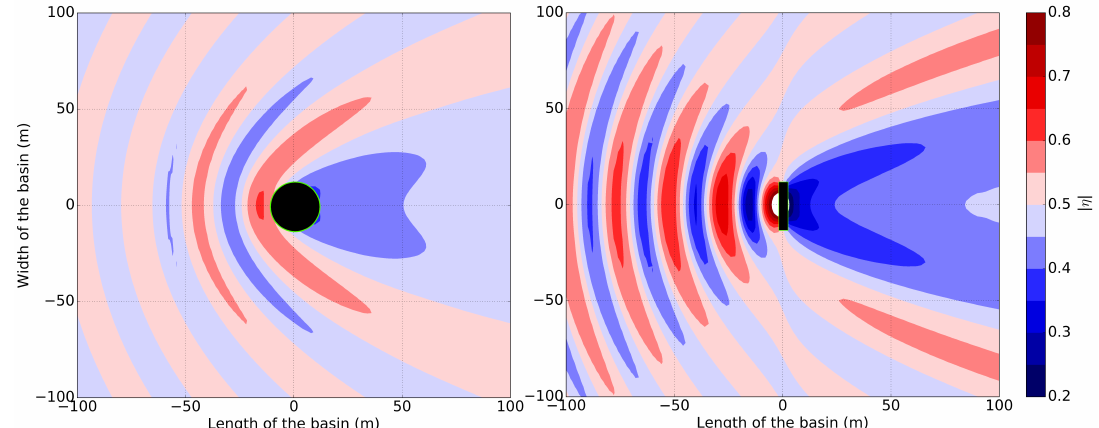
Figure 7. Modulus of the total surface elevation | η | for a heaving buoy WEC ( left ) and OSWEC ( right ). Incident wave of H = 1.0 m, T = 6.0 s propagating from the left.